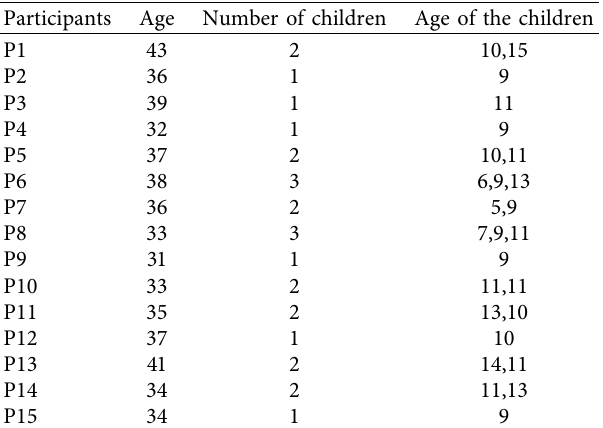
Table 2: Anonymous visualization of the participants with the letter P along with the participant